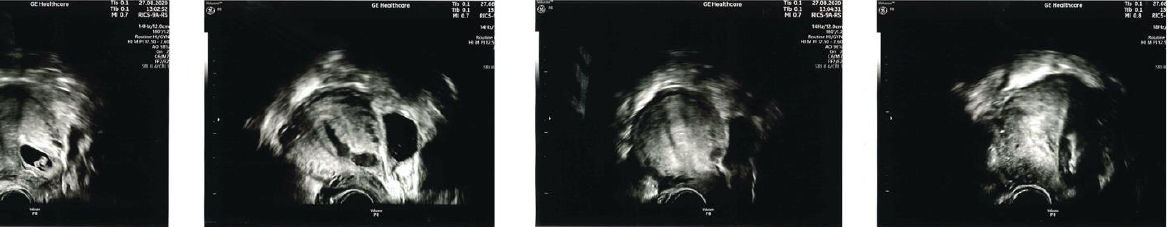
Figure 3. Intraoperative transrectal ultrasound guidance is crucial to ensure complete evacuation of the uterine cavity and caesarean scar niche.